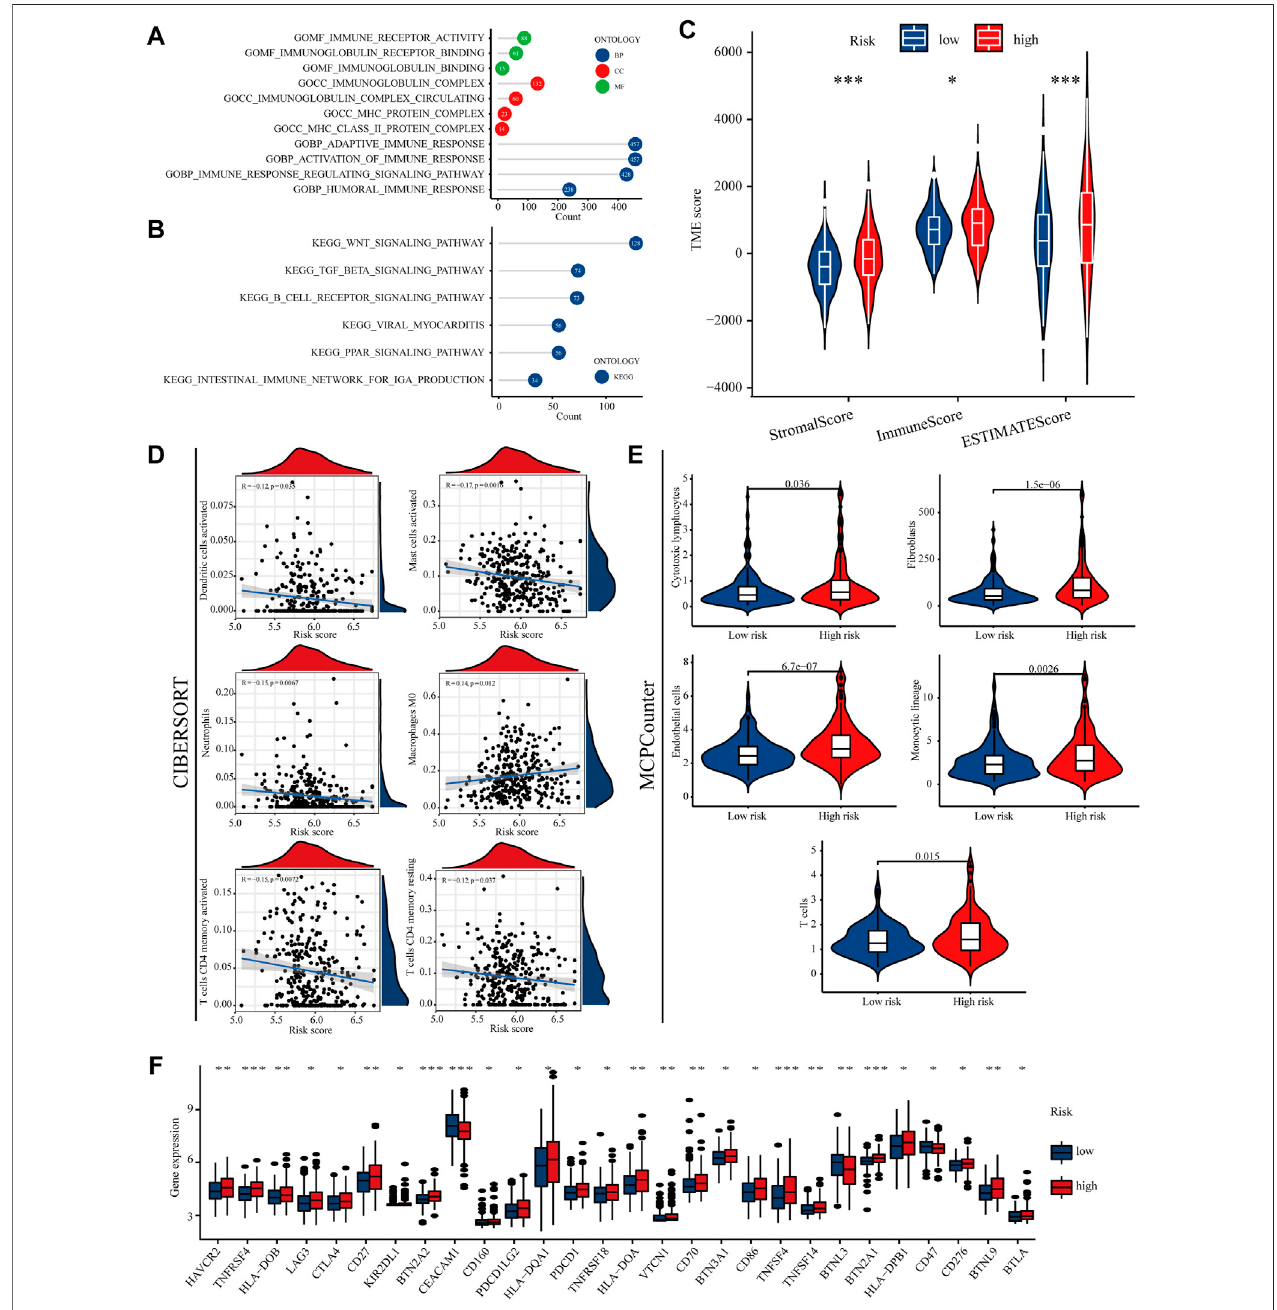
FIGURE 7 | Immune features in high- and low-risk groups (A,B) Different GSEA result between high- and low-risk groups (C) immune microenvironment scores betweenthehigh-andlow-riskgroups (D,E) MCPcounterand CIBERSORTwereusedtocalculatetherelativeproportionsofimmunecellsubsets (F) Theexpressionof immune checkpoints between the high- and low-risk